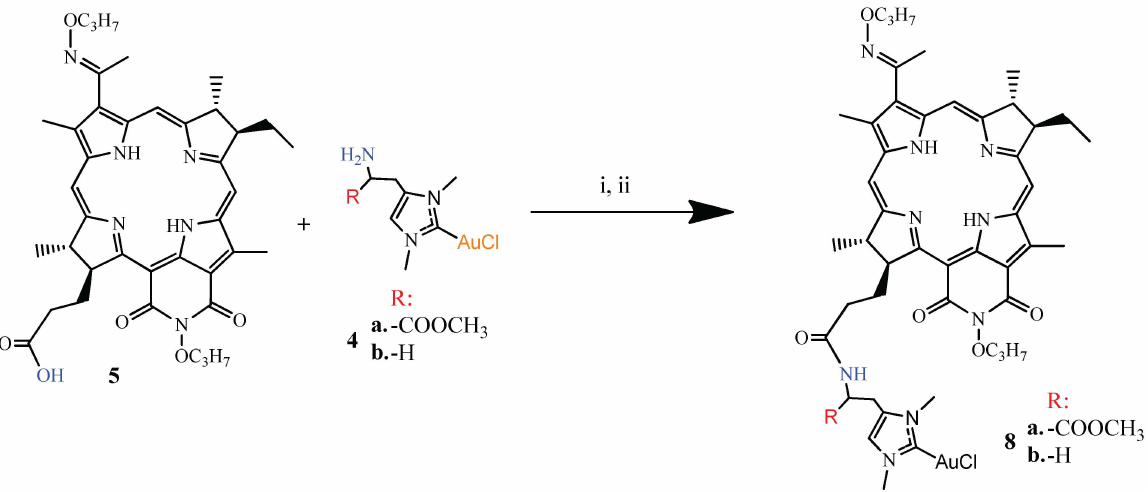
Scheme 4. Reagents and conditions: (i): 1. CH 2 Cl 2 , EDC, NHS, 0 ◦ C, 1 h. 2. compound 4a , Et3N, 36 h; (ii): 1. CH 2 Cl 2 , EDC, NHS, 0 ◦ C, 1 h, 2. compound 4b , Et3N, 36 h, Ar. Int. J. Mol. Sci. 2022 , 23 , x FOR PEER REVIEW The compounds obtained exhibited some changes in the absorption spectra and a reduction in the fluorescence intensity by 30–40% (Figure 2).